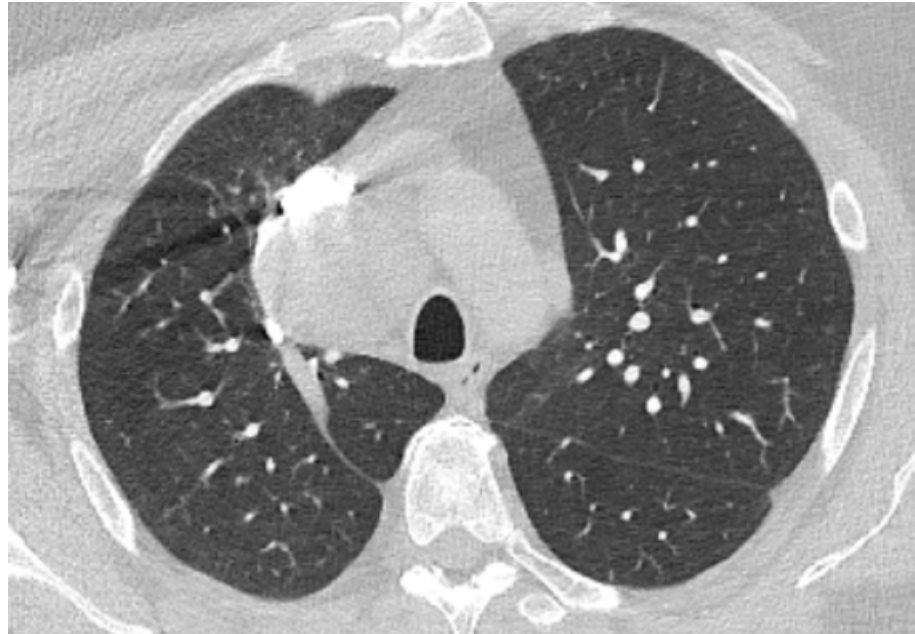
Figure 5. Native chest computer-tomography in the context of confirmed SARS-CoV-2 infection: fine areas of ground glass arranged peripherally classified as minimal lung damage.